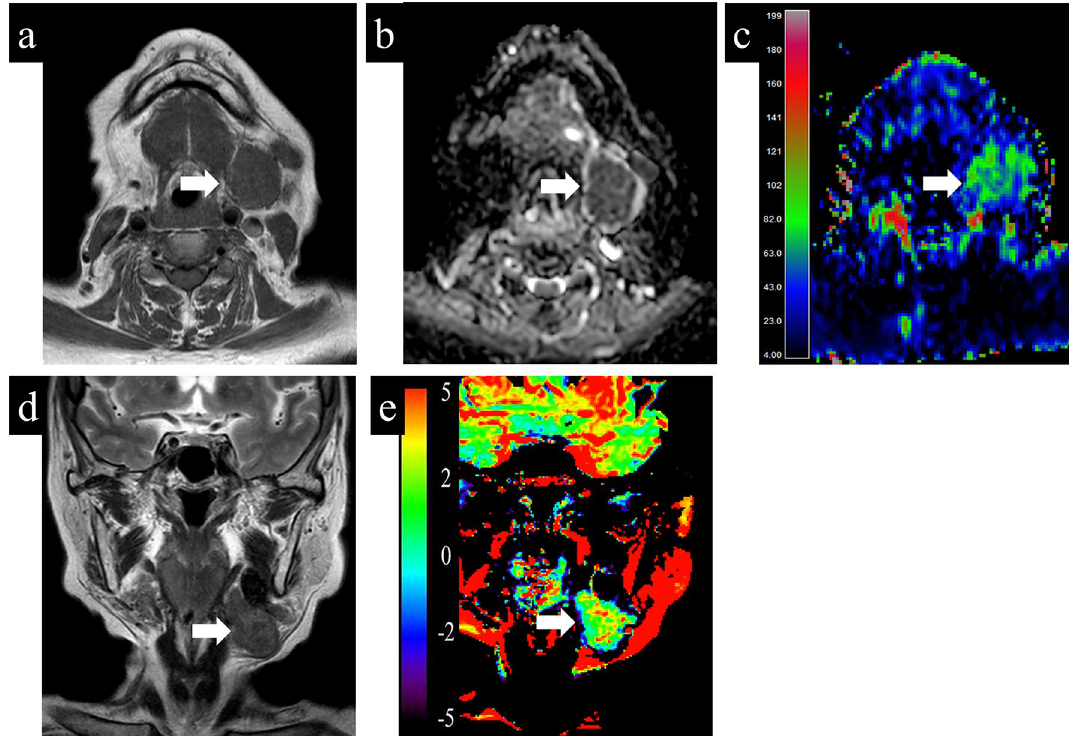
Figure 6. A 75-year-old female with carcinoma ex pleomorphic adenoma. ( a ) T1-weighted image shows a homogeneous low intensity lesion in the left parotid gland. Apparent diffusion coefficient (ADC) ( b ) and tumor blood flow (TBF) ( c ) maps show the lesion with the mean ADC value of 0.91 × 10 −3 mm 2 /s and the mean TBF value of 67.96 mL/100 g/min, respectively. On T2-weighted coronal image ( d ), the lesion shows slightly higher signal intensity compared to muscle structure. Amide proton transfer (APT) ( e ) map shows the lesion with the mean APT signal intensity of 2.65%. An arrow in each image indicates the